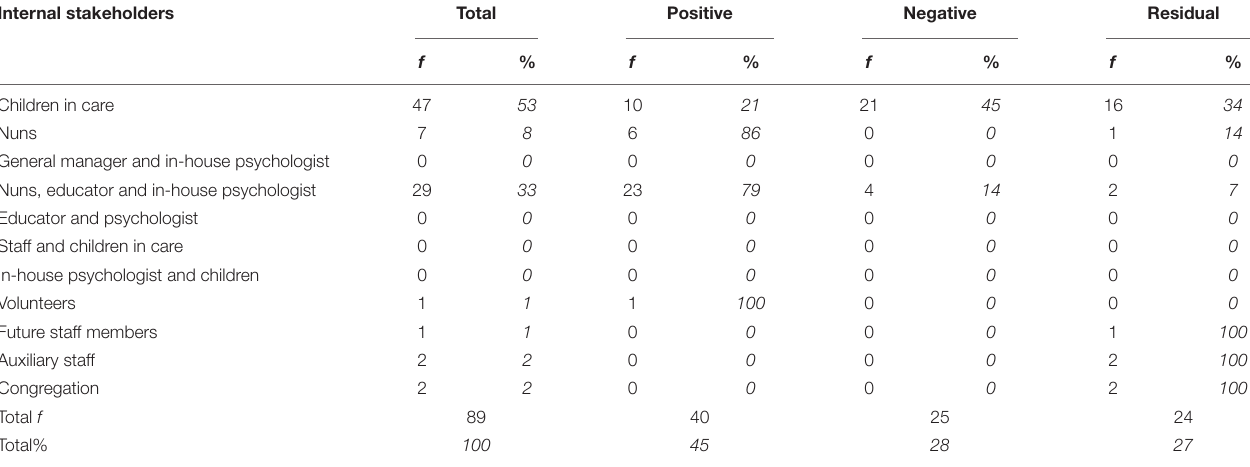
TABLE 2 | Frequency and percentage of internal stakeholder (ingroup) qualifying